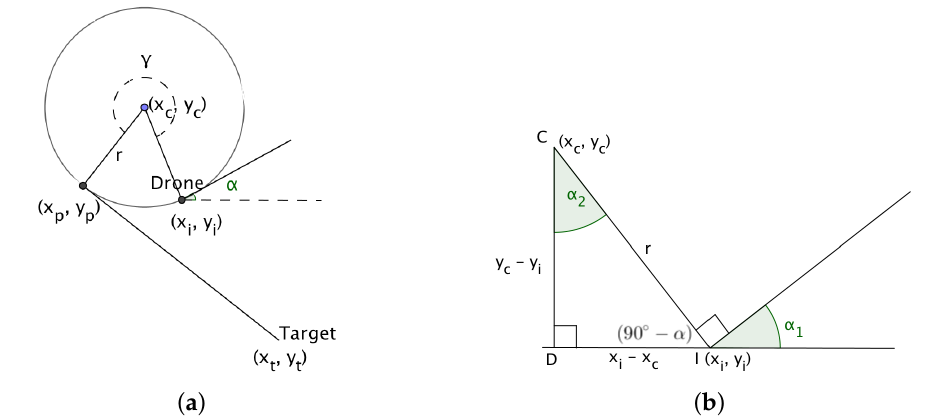
Figure 6. ( a ) Calculating the center of the circle when the target lies to the right of the path of the drone; ( b ) Calculating the center of the circle given the initial position, angle of the drone and the